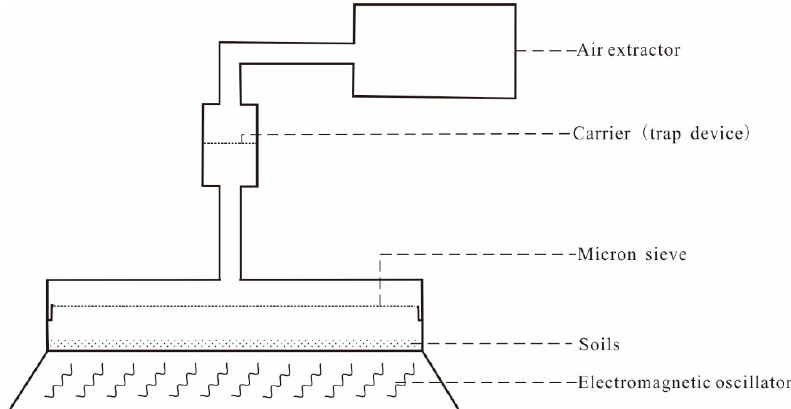
Figure 2. Schematic drawing of the device for separating nanoparticles for soils.